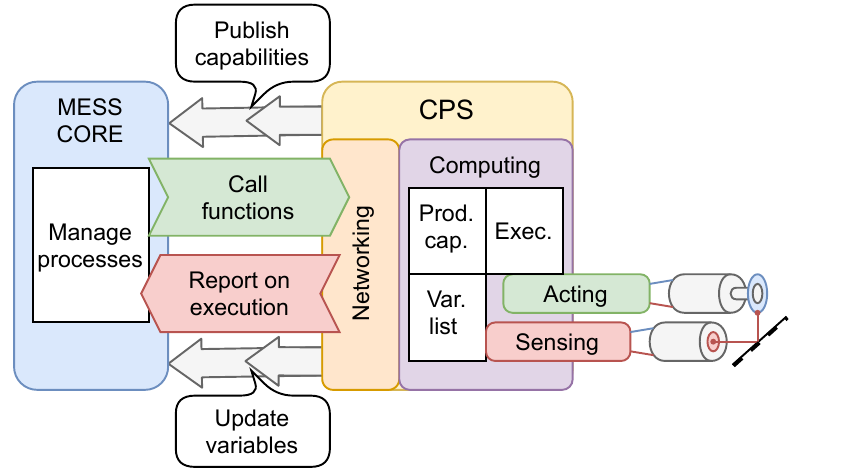
Figure 2. High-level concept of the MESS